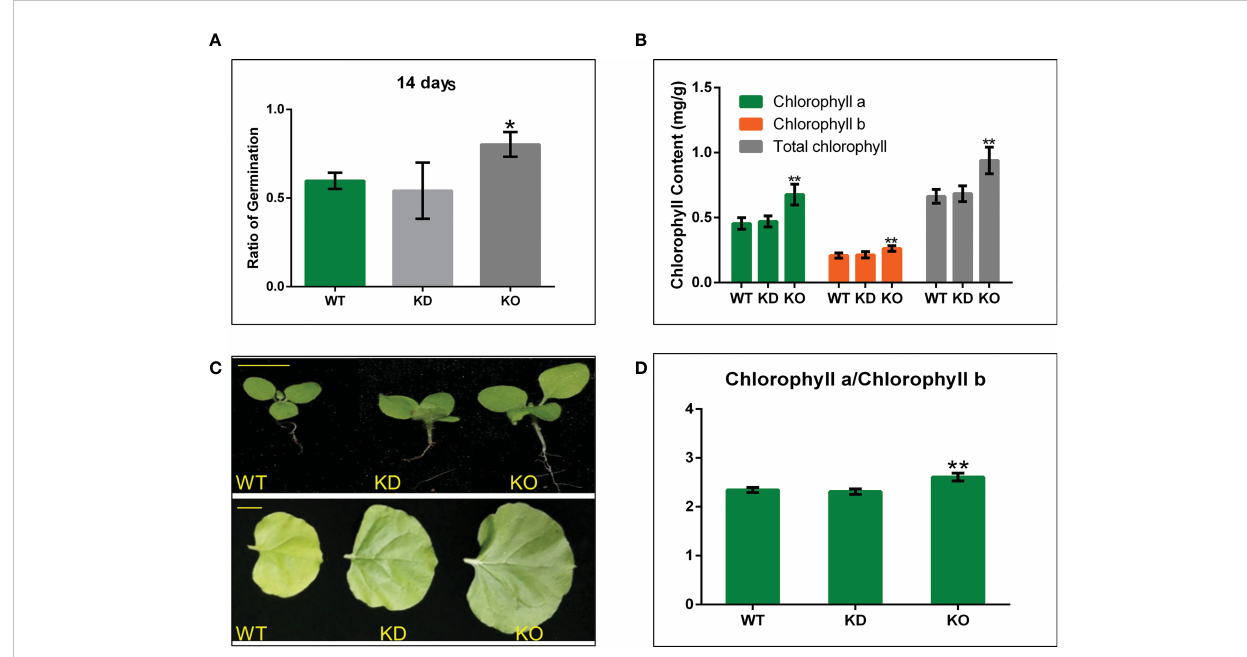
FIGURE 2 NbBI-1 regulatory role in the growth and development of N. benthamiana and NbBI-1 knockout reduce resistance to abiotic stresses. (A) Shows seeds germination rate after 14 days of sowing. (B) Growth and development N. benthamiana . Row 1, seedling size (14 days after sowing. Bar, 1cm), and Row 2 (record after 4 weeks of seeding. Bar, 2cm). (C, D) NbBI-1 inhibit chlorophyll contentin N. benthamiana . Chlorophyll a, chlorophyll b, Total chlorophyll, and the chlorophyll a/b ratio; in N. benthamiana leaves. Data are mean ± SEM, asterisks indicate a signi fi cant difference (Student ’ s t-test, test, *: 0.01<P<0.05, **: